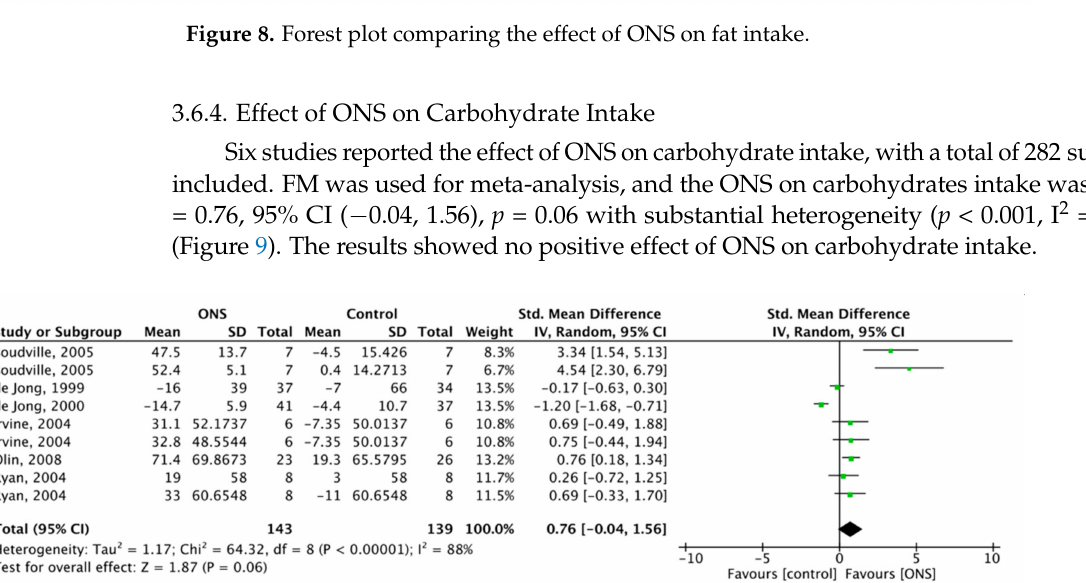
Figure 9. Forest plot comparing the effect of ONS on carbohydrate